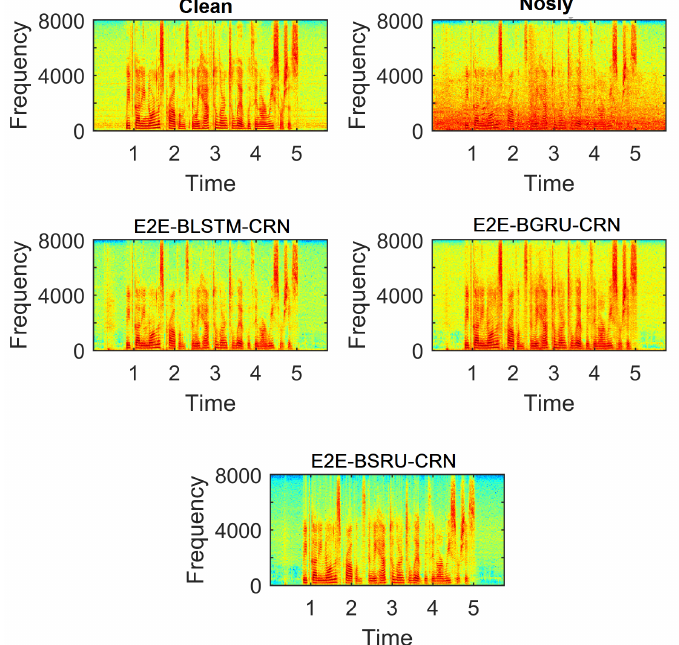
Figure 9. Example Spectrograms of Speech utterance degraded by − 5 dB Babble Noise. The spectro- grams of three E2E models show less residual